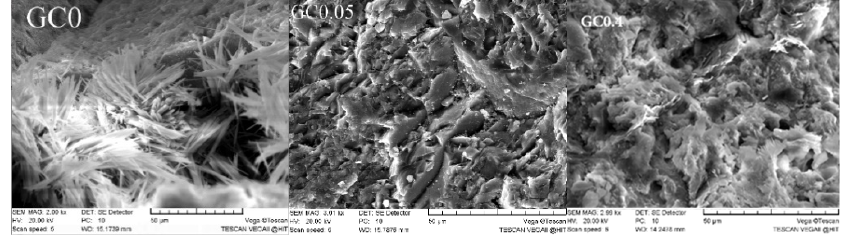
Figure 2. SEM images of the specimens before freeze-thaw tests.